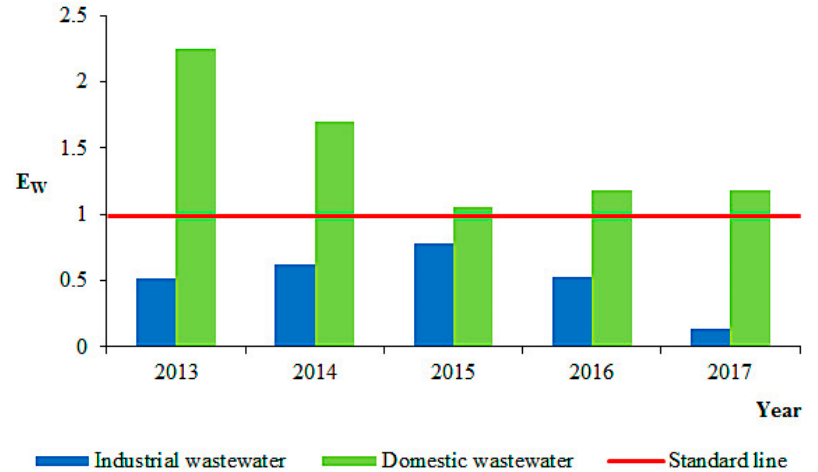
Figure 8. The elasticity coefficients between industrial (or domestic) wastewater emissions and water use.